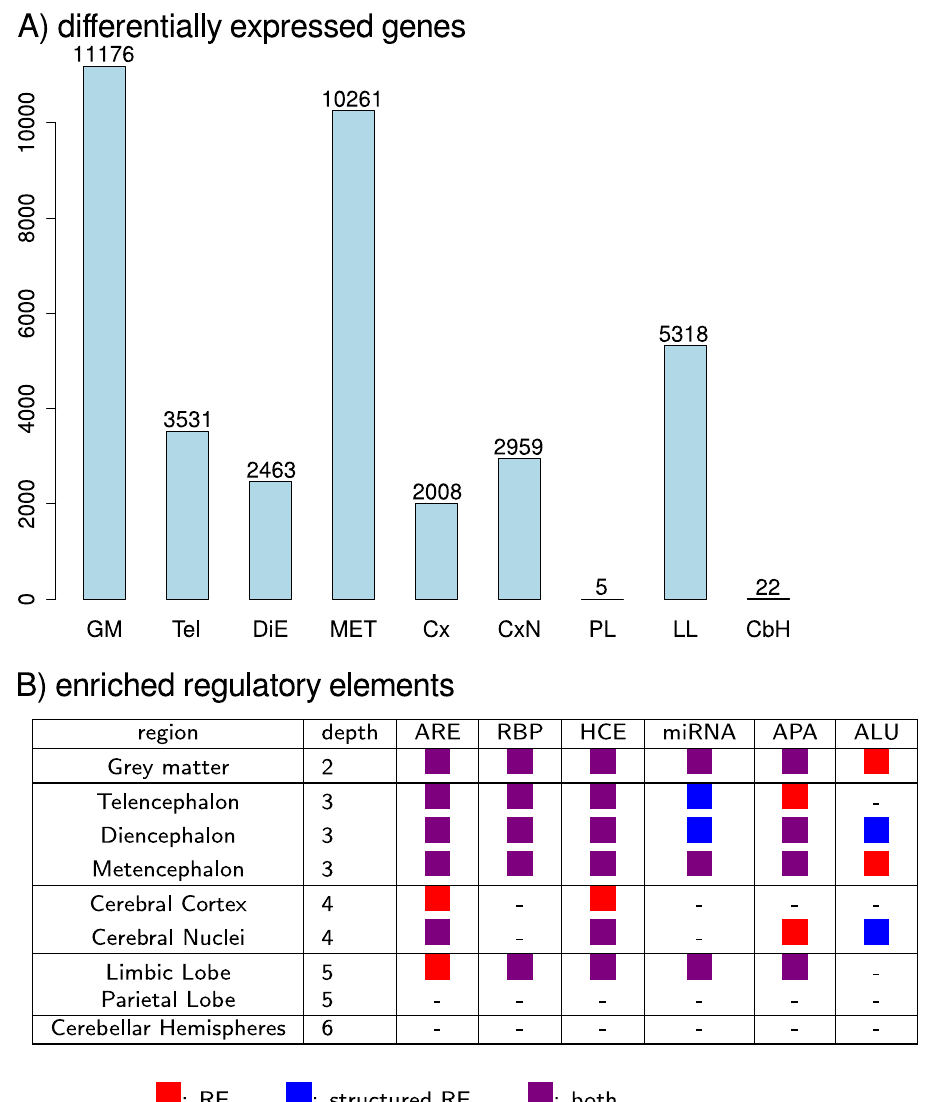
Figure 2. Enriched structured regulatory elements in differentially expressed genes. ( A ) The number of differentially expressed genes between any two sub-regions of the indicated region. ( B ) Enriched regulatory elements for the set of differentially expressed genes. RE refers to regulatory elements. If a RE overlaps with a RNA secondary structure predictions it is referred to as structured